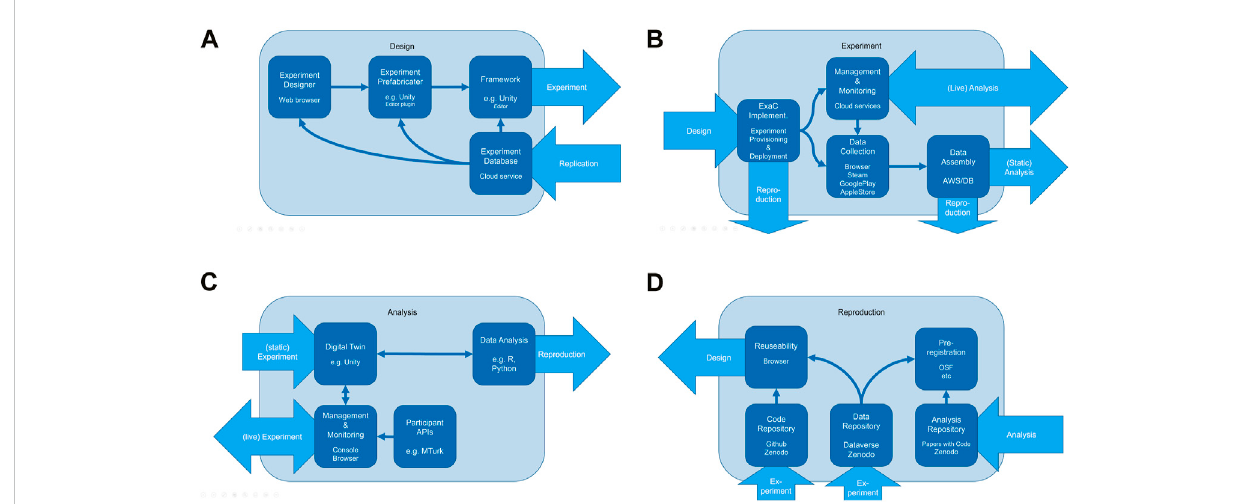
FIGURE 2 DEAR principle has four distinct faces that work in a circular pattern. (A) Design phase provides users with a simpli fi ed interface to set up standard variants of known experiments from a database. It prepares the experiment and offers the opportunity to advanced users to adjust the experiment. (B) Experiment phase uses the Experiments as Code paradigm to automatically deploy the experiment to a suitable platform, engage participants, manage the experiment, and collect data. (C) Analyse phase of an experiment employs a digital twin of the experiment to monitor the progress of the experiment, recruit participants into the experiment, and statistically evaluate the data. (D) Reproduce phase gathers the experiment code, the collected data, and the analysis scripts into long-term repositories. These repositories are in turn indexed in the experiment database for the design